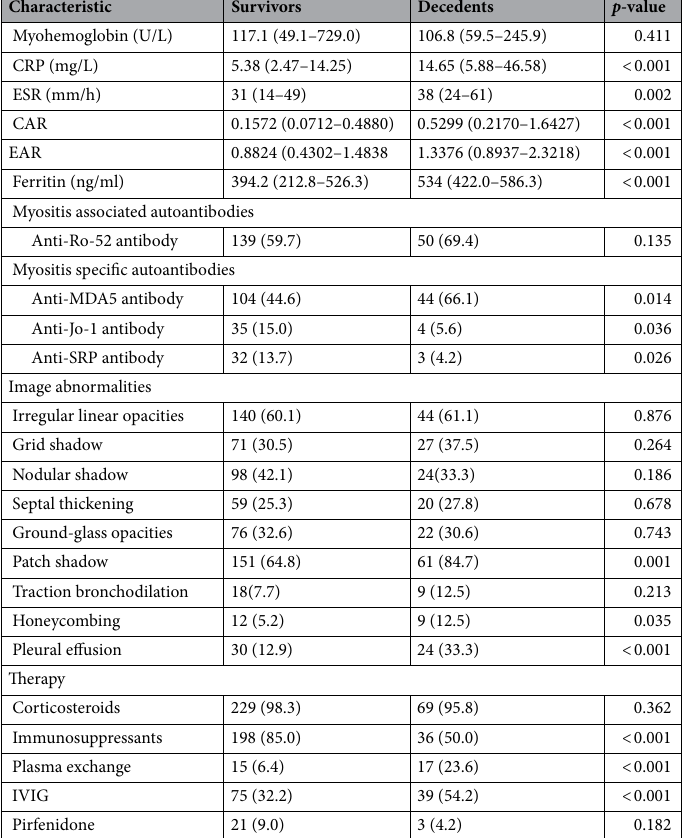
Table 3. Comparison of clinical characteristics between survivors and decedents group in IIM-ILD patients. Values are presented as number (%) or median (range). ILD, interstitial lung disease; ESR, erythrocyte sedimentation rate; CRP, C-reactive protein; NLR, Neutrophil-to-lymphocyte ratio; PLR, platelet-lymphocyte ratio; CAR, the C-reactive protein to albumin ratio; EAR, the erythrocyte sedimentation rate to Albumin ratio; IVIG, intravenous immunoglobulin.